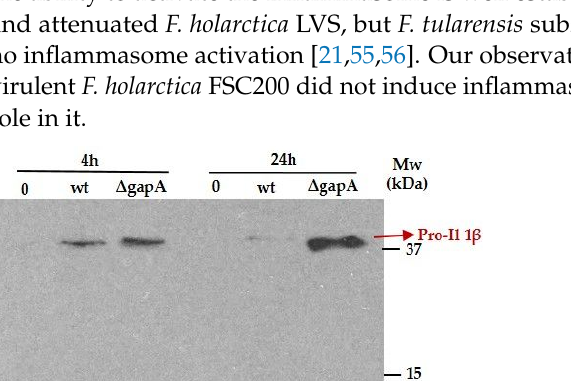
Figure 7. Real-time qRT-PCR quantification of selected cytokines in BMDMs infected with wt or ∆ gapA strains for 8 h. Results were compared to uninfected cells (control). Data are presented as a fold change in expression relative to control cells (set at 1). Data are shown as mean ± SEM. ** p ˂